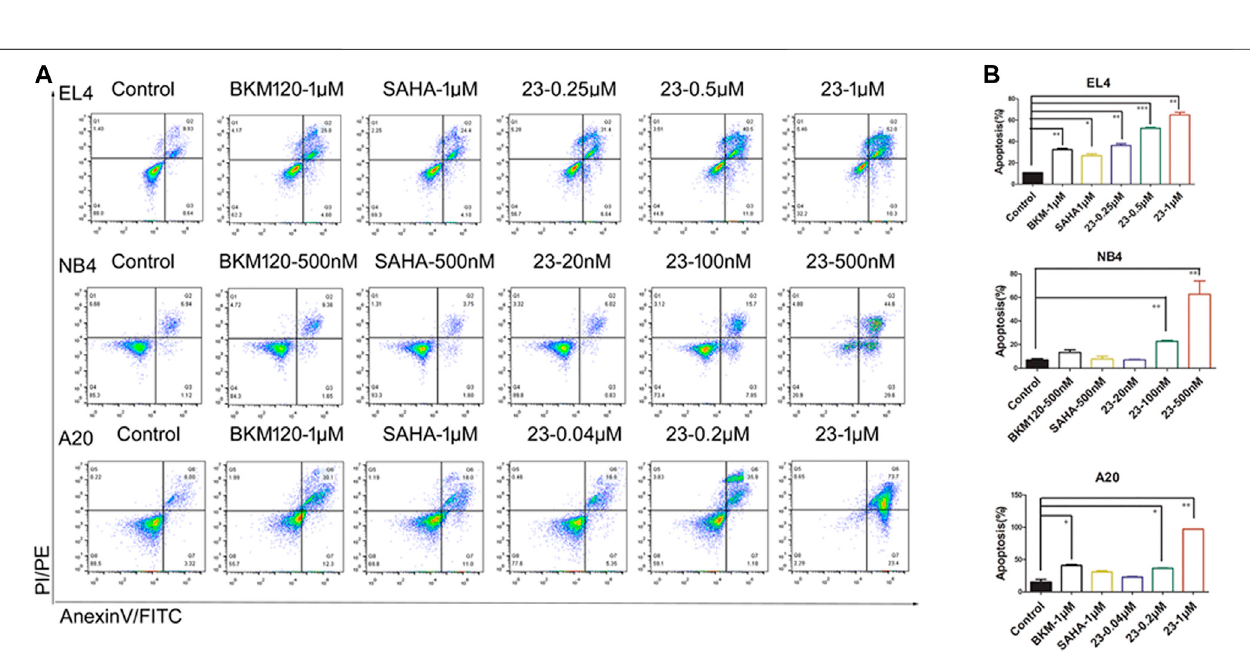
Frontiers in Pharmacology |